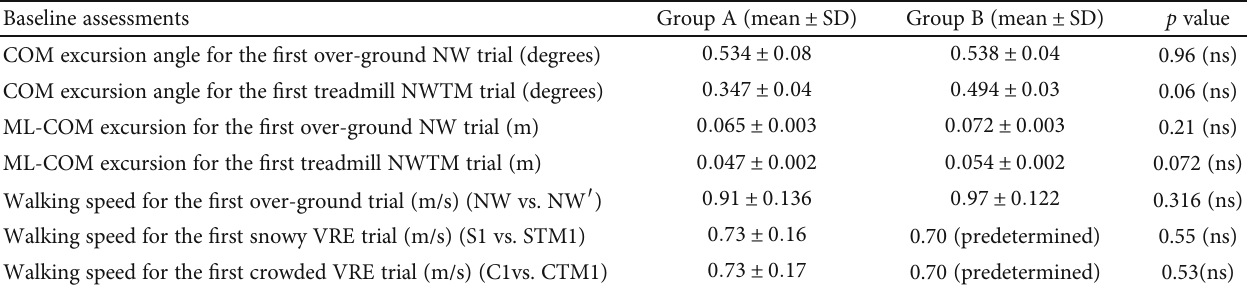
Table 2: Between-group comparisons of baseline COM excursion angles and ML-COM excursions during the fi rst natural walking trial (NW) for over-ground and treadmill (NWTM) walking, and between-group comparisons of walking speed during NW, NW ′ , and during the fi rst exposure to VRE (snowy and crowded